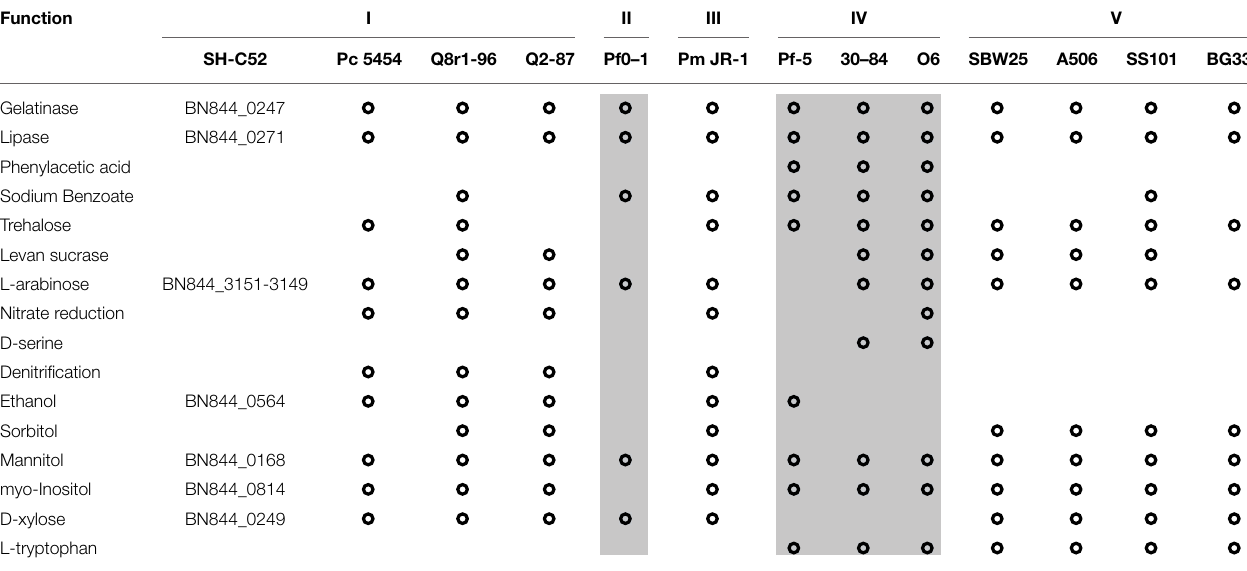
TABLE 2 | Primary metabolism and corresponding genes of Pseudomonas SH-C52.